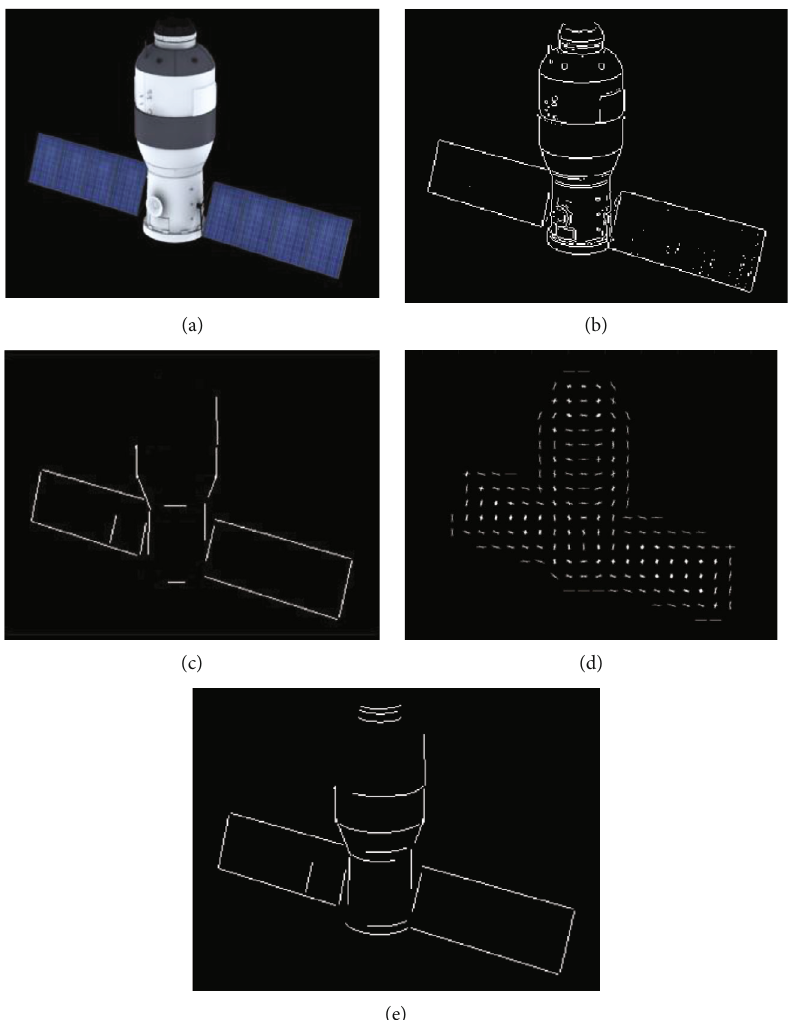
Figure 9: Di ff erent image features: (a) the original image, (b) the edge of the image, (c) the line feature, (d) the HOG feature, and (e) the image feature adopted in our method.